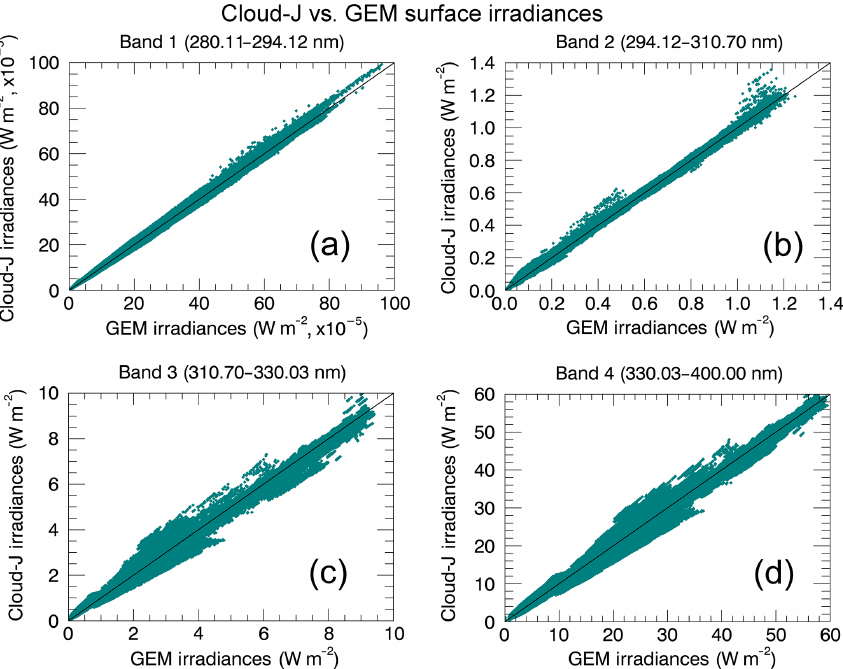
Figure 8. Calibrated GEM broadband irradiances, corrected using the total irradiance scaling functions found in Table 1, compared to the simulated GEM broadband irradiances produced by